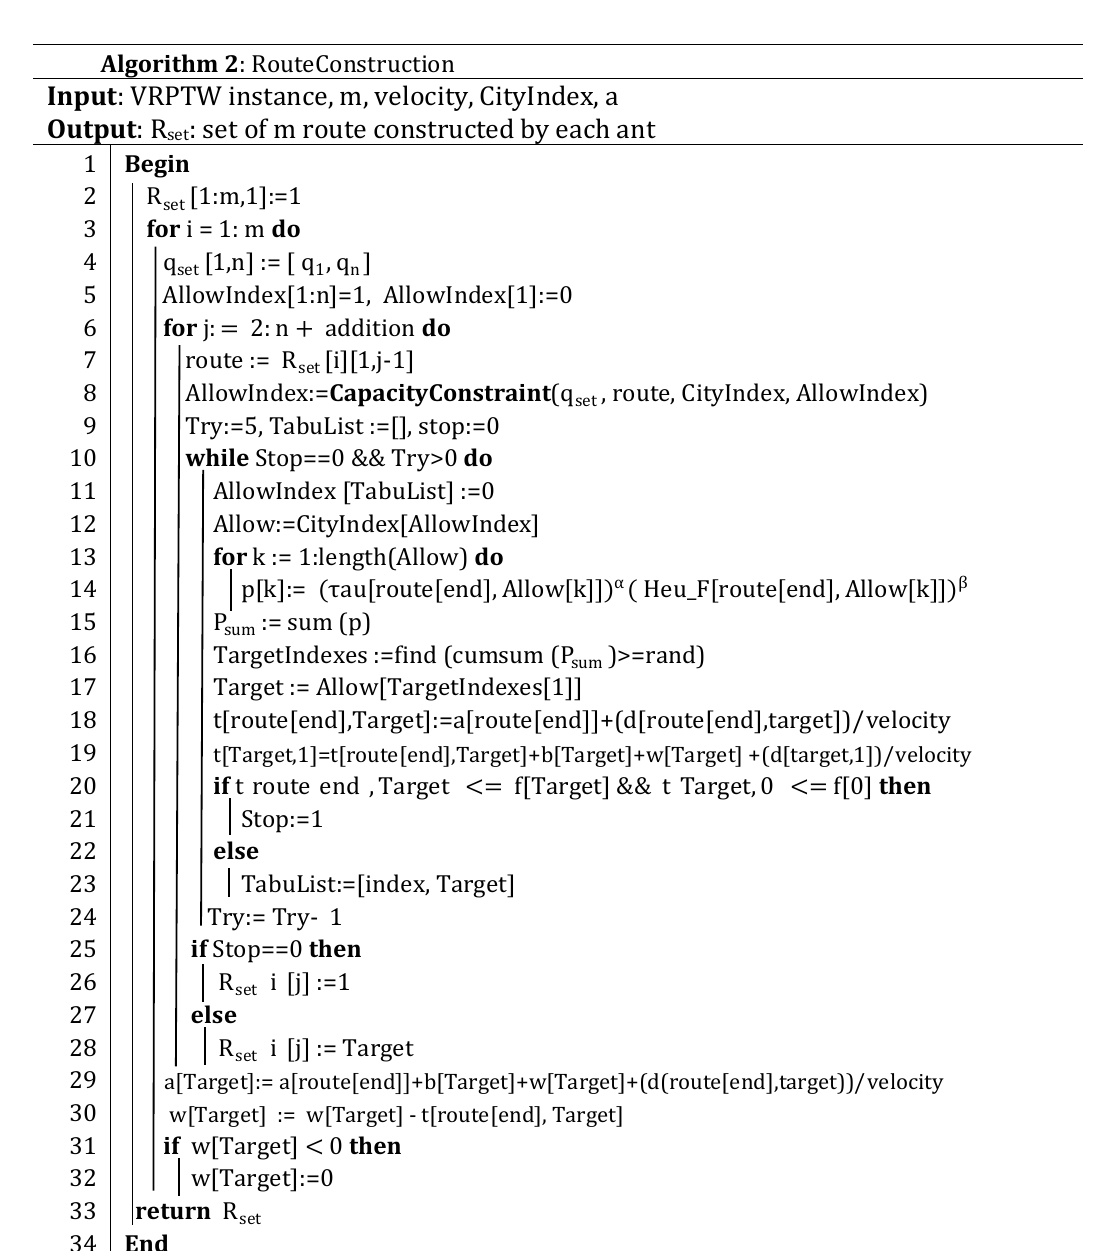
Algorithm 3 takes as input the set of